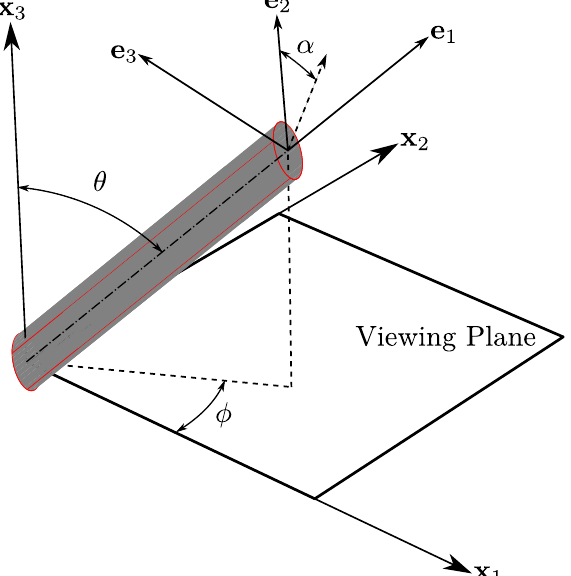
Figure 3. An elliptical fiber in space showing the three angles that define its